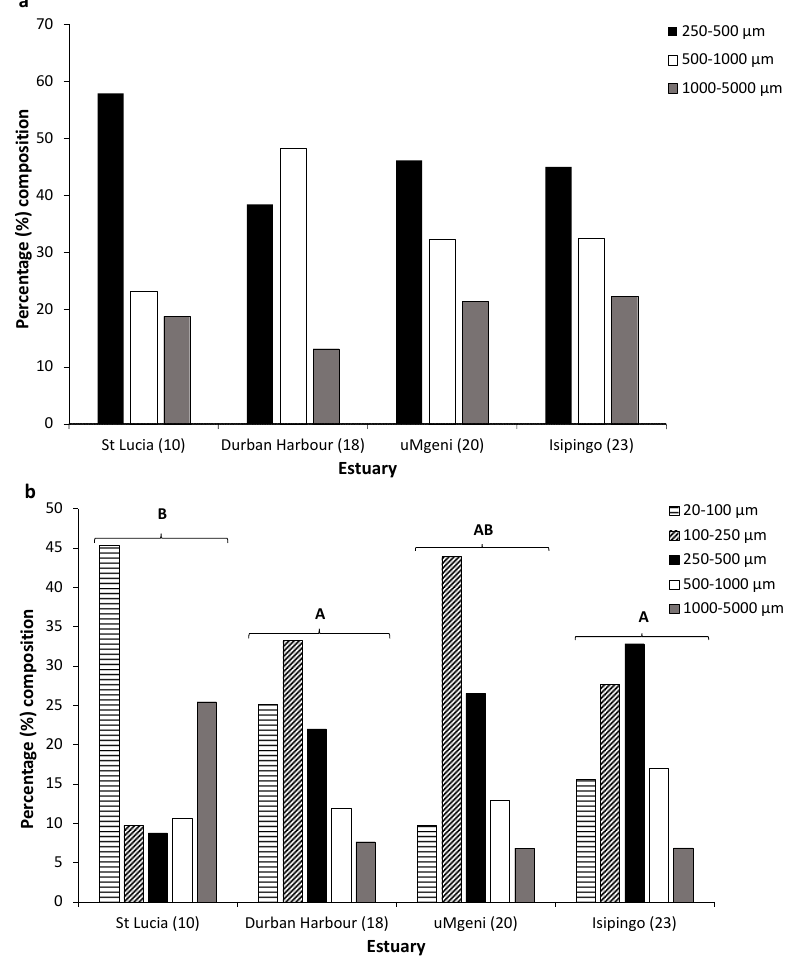
Figure 7. Size class distribution of microplastics for ( a ) surface water (n = 12) and ( b ) mangrove sediment (n = 18) at the four estuaries sampled. Uppercase letters indicate significant differences in the size distribution of MPs across estuaries based on combined seasonal data ( p = 0.002 for ( b ); ANOVA). The total disturbance score (TDS) is given within brackets for each estuary on the x-axis.